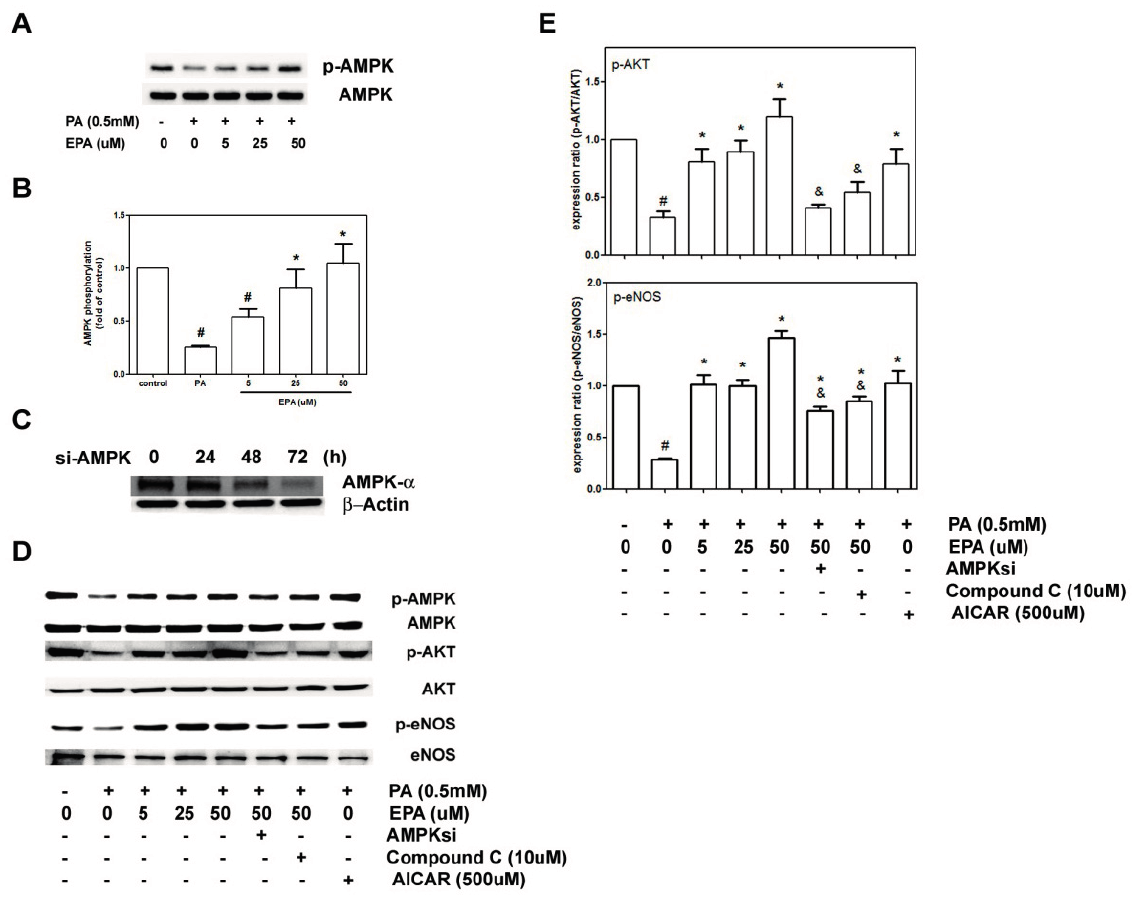
Figure 6. Effects of EPA on PA-induced AMPK activation. ( A ) The HUVECs were pretreated with EPA for 2 h and subsequently treated with 0.5 mM PA for 18 h. Phospho-AMPK and AMPK expression were subjected to western blot analyses; ( B ) The quantifications of the related phospho-AMPK and total AMPK are shown; ( C ) The cells were transiently transfected with AMPK α 1 siRNA for 24, 48 or 72 h. The expression levels of phospho-AMPK and total AMPK in the transfected HUVECs were determined